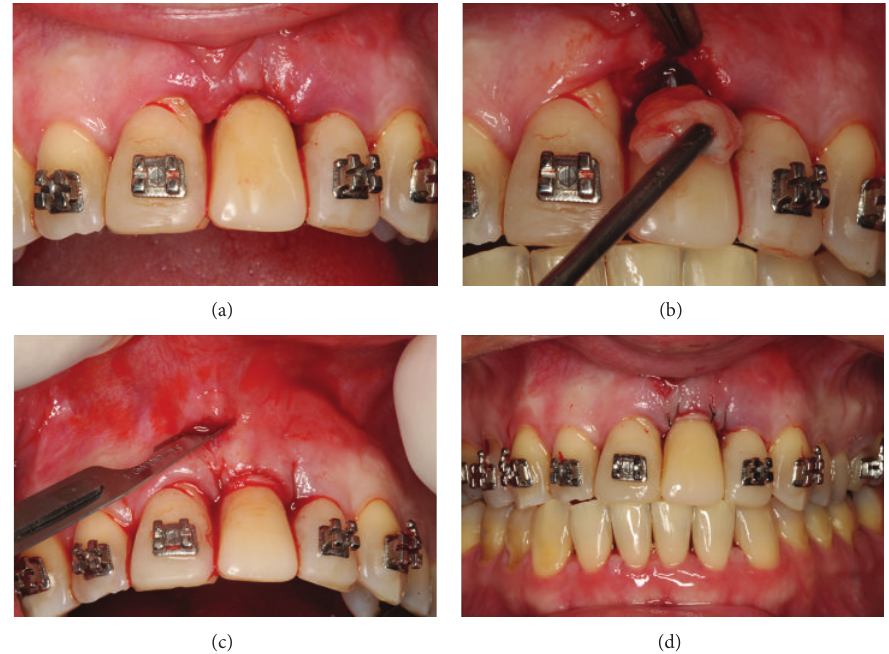
Figure 9: Installation of a provisional crown followed by autogenous connective tissue graft, frenum removal, and simple suture.